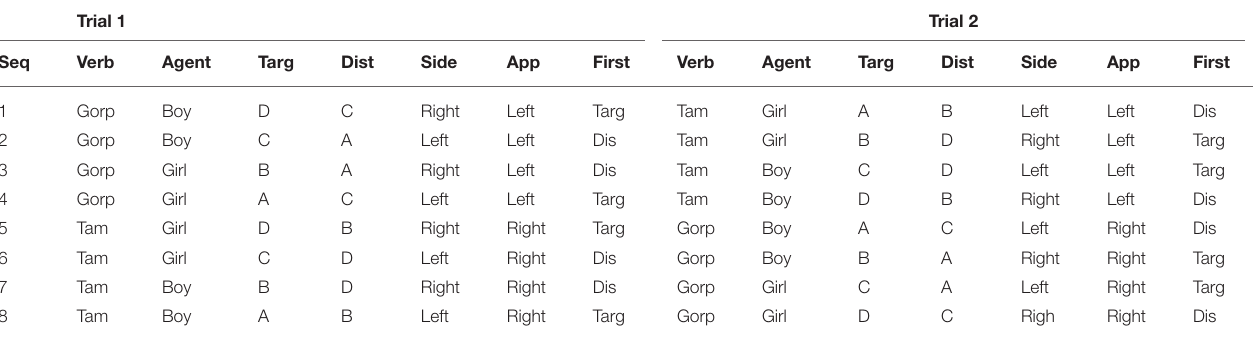
TABLE 1 | Counterbalancing sequences for the Intermodal Preferential Looking (IMPL) task. Trial